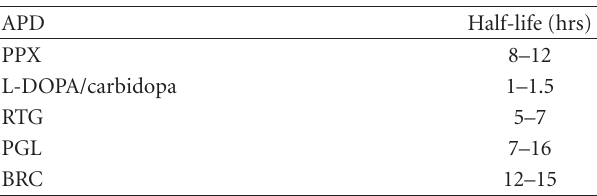
Table 2: Pharmacokinetic profiles of selected anti-Parkinson’s